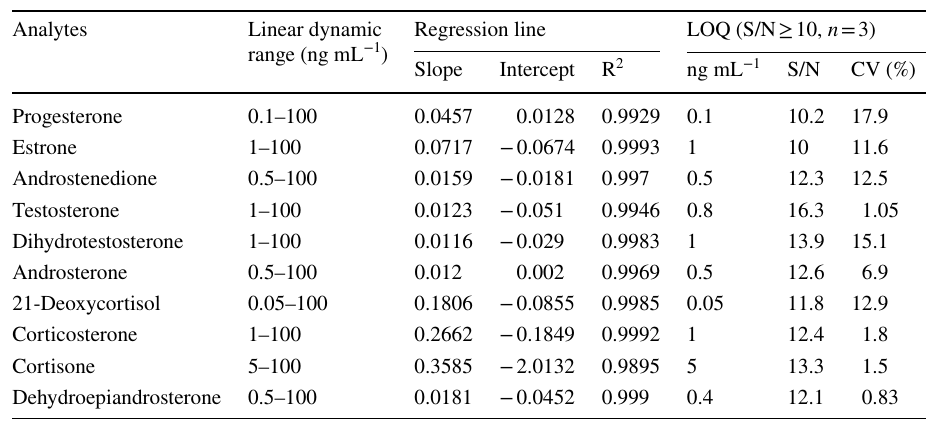
Table 2 Calibration curve and LOQ for the ten steroid hormones